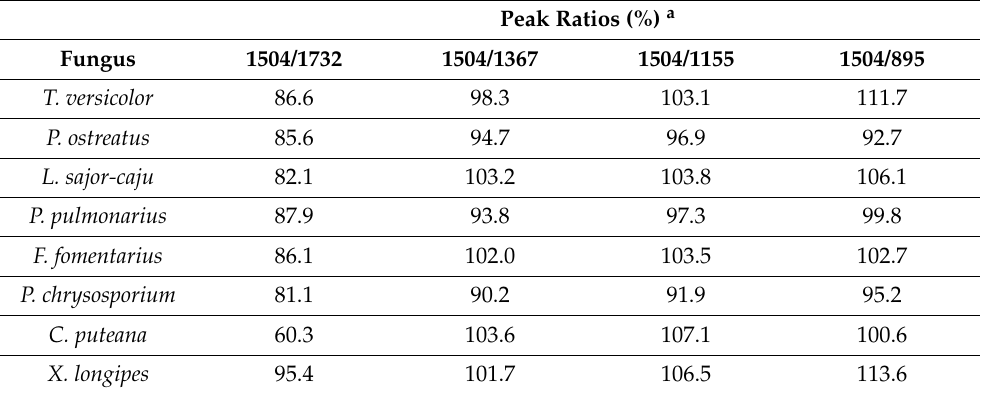
Table 2. Effect of fungal exposure on the FTIR spectra, as shown by ratios between lignin and the various carbohydrate fractions.